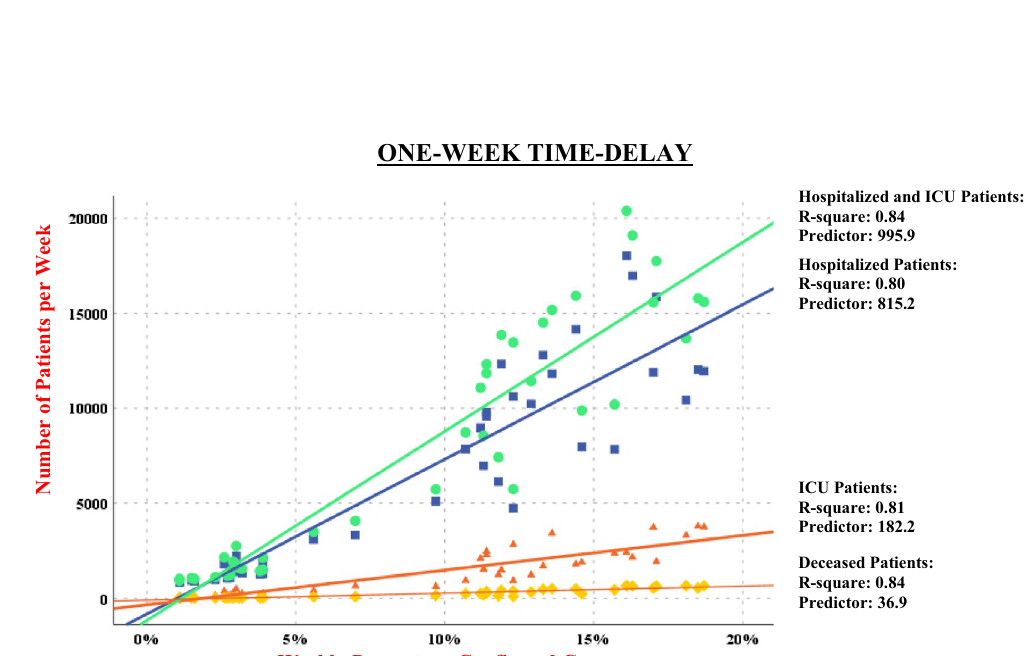
Figure 2. Linear distributions from March to December 2020 with 1 week